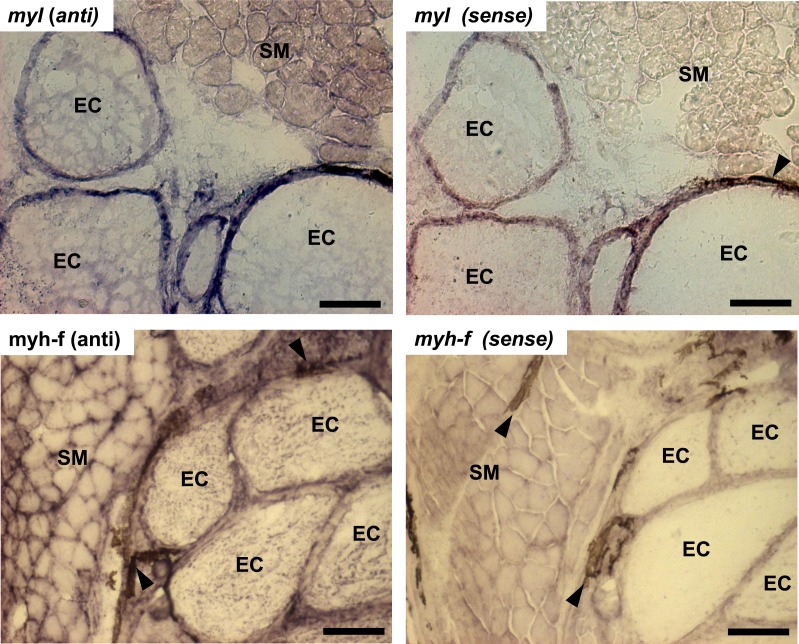
In situ hybridization of muscle and electrocytes using probes against myosin light chain and fast-myosin heavy chain.Portions of transverse cryosections (16 µm-thick) taken from tails of control fish and processed for in situ hybridization. Antisense (anti) DIG-labeled RNA riboprobes specific to S. macrurus myosin light chain (myl) and sarcomeric fast myosin heavy chain (myh-f) transcripts were used for detection of these mRNAs in skeletal muscle fibers and electrocytes (EC). Sense strand DIG-labeled riboprobes against myosin light chain (myl) and sarcomeric fast myosin heavy chain (myh-f) were used as negative controls. Melanin is the dark brown pigment found around muscle fibers and electrocytes (arrow heads). Abbreviations: SM, skeletal muscle fibers; EC, electrocyte. Scale bar, 100 µm.